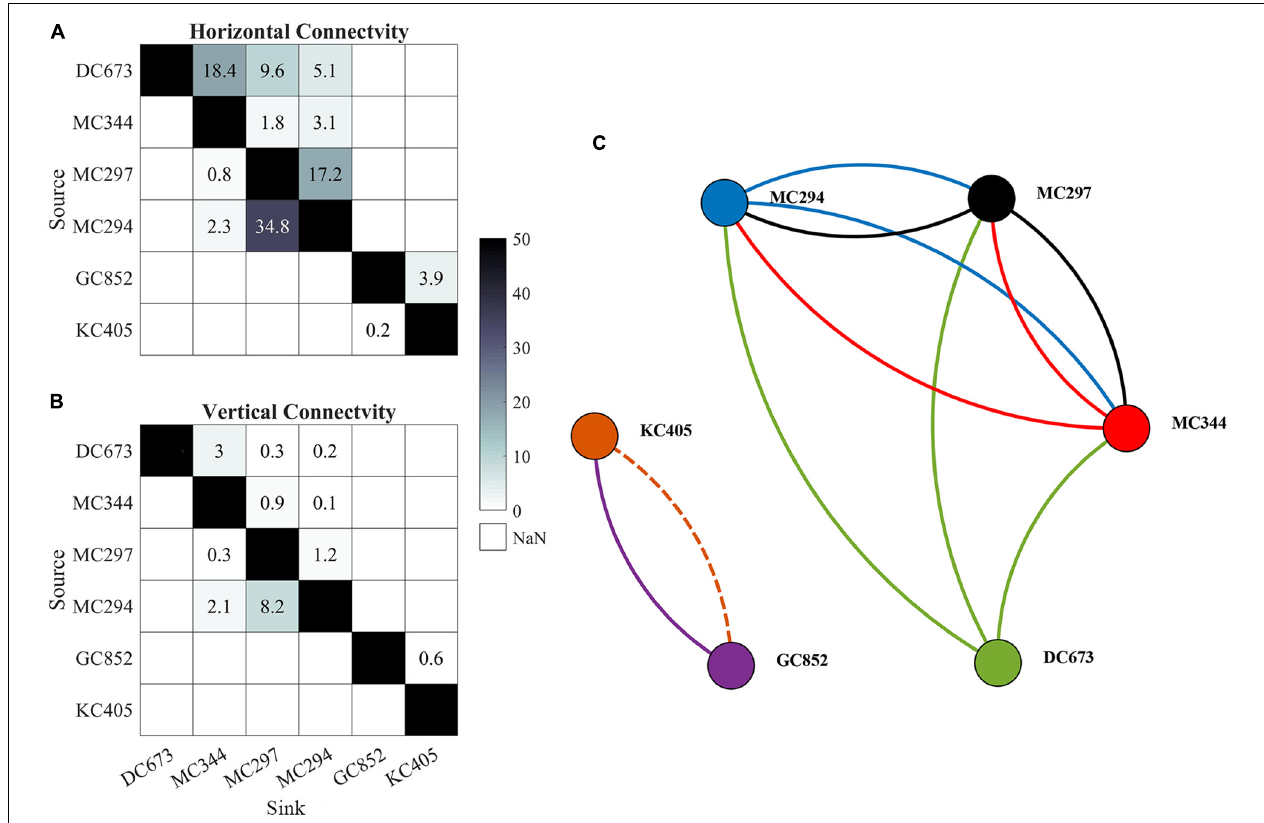
FIGURE 7 | Horizontal l h (A) and 3D l v (B) connectivity probability (%) matrices and connectivity network (C) calculated from the Lagrangian simulations performed over 56 days in February, May, and August, and 148 days in November. Line colors indicates the source site for each connection. Solid lines indicate three-dimensional connectivity and the dash line represents horizontal connection only. Line width does not correspond to the magnitude of connectivity. Sites are arranged from east to west (from DC673 to